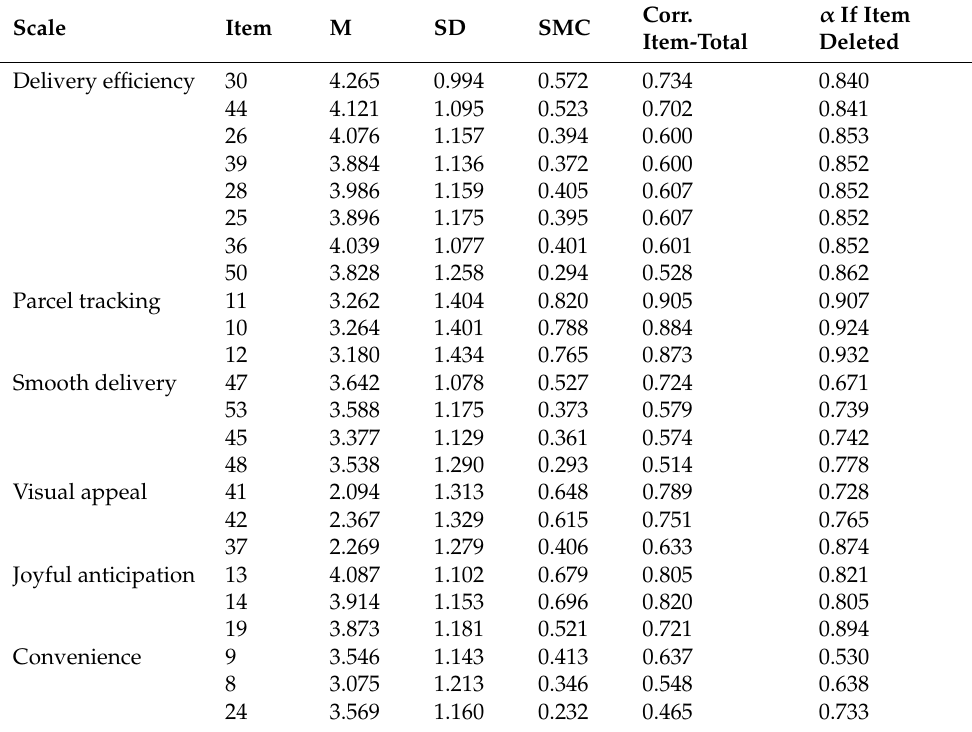
Table 3. Psychometric properties and gender differences of the CDX-LMD scales ( N = 907).